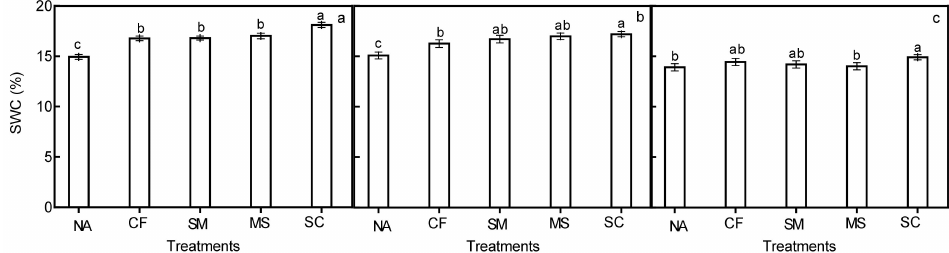
Figure 5. Mean soil water content (SWC) by soil amendment treatment in maize in 2014 ( a ), 2015 ( b ), and 2016 ( c ). NA, no amendment; CF, chemical fertilizer; SM, swine manure; MS, maize stover; and SC, swine manure + chemical fertilizer. Within a year, bars with di ff erent letters are significantly di ff erent ( p ≤ 0.05). Error bars denote standard